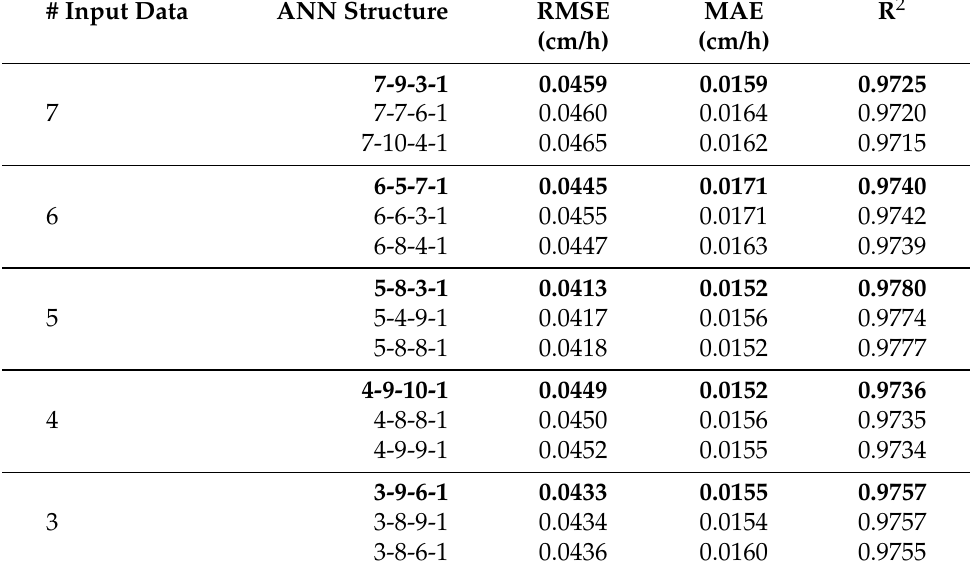
Table 2. The top three configurations for ANN structure and their statistical measurements. (1) # Input data (2) contains the ANN neurons’ structure (Input-Hidden1-Hidden2-Ouput), where each number represents the quantity of neurons used in each layer, (3) the RMSE measurements, (4) the MAE measurements, and (5) the R 2 measurements.